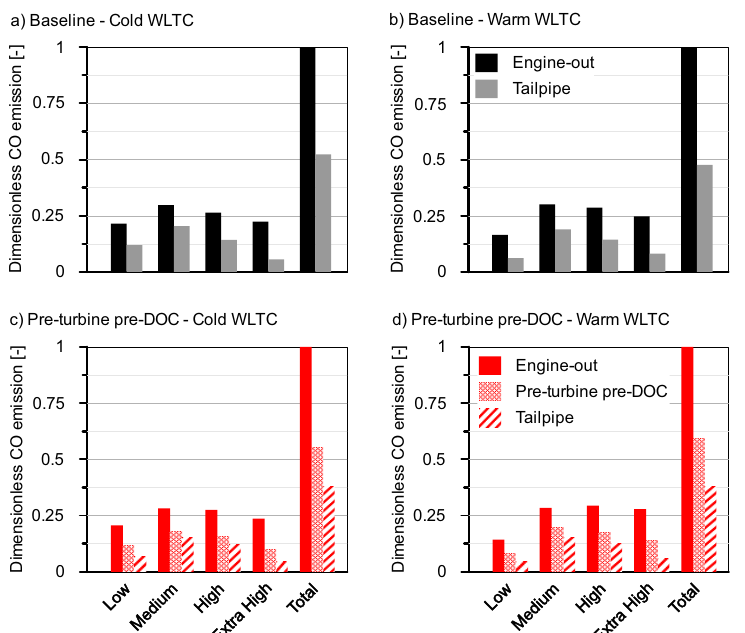
Figure 9. Normalized cumulative CO emission along the exhaust line in every WLTC phase in cold and warm tests with baseline ATS and pre-turbine pre-DOC configuration. ( a ) Baseline configuration in cold WLTC, ( b ) Baseline configuration in warm WLTC, ( c ) Pre-turbine pre-DOC configuration in cold WLTC, ( d ) Pre-turbine pre-DOC configuration in warm